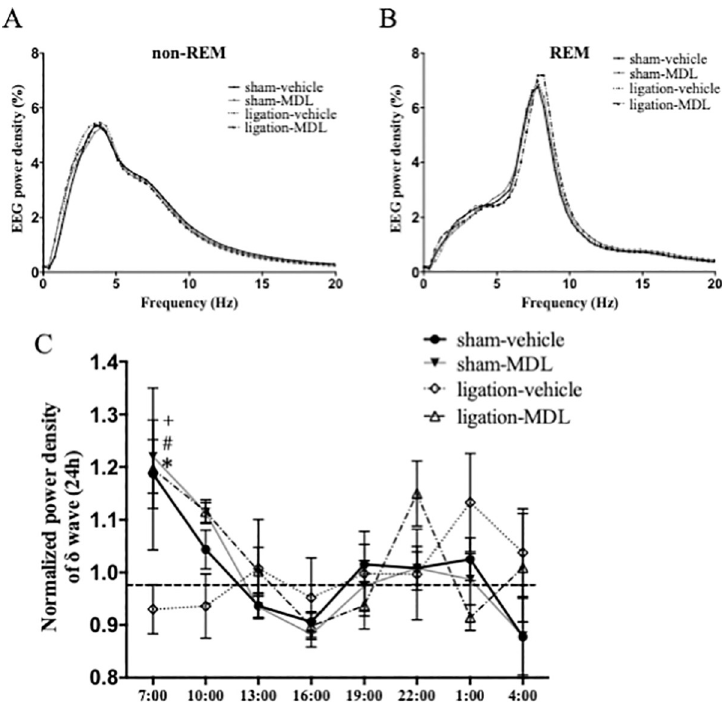
Fig 7. Selective 5HT 2A receptor antagonist improved quality of sleep in neuropathic pain model. Distribution of EEG power density in each frequency during non-REM and REM sleep. Data are expressed as means only (A). Time changes of the normalized power density of δ wave are plotted every 3 hours in sham (n = 6) and nerve ligation (n = 5) mice. Data are expressed as means ± SEM (B). Data are analyzed using two-way ANOVA followed by Bonferroni’s post hoc test and considered statistically significant at � P < 0.05 when comparing the sham-vehicle and ligation- vehicle groups, # P < 0.05 when comparing the ligation-vehicle and ligation-MDL 100907 groups, and + P < 0.05 when comparing the sham-amitriptyline and ligation-vehicle